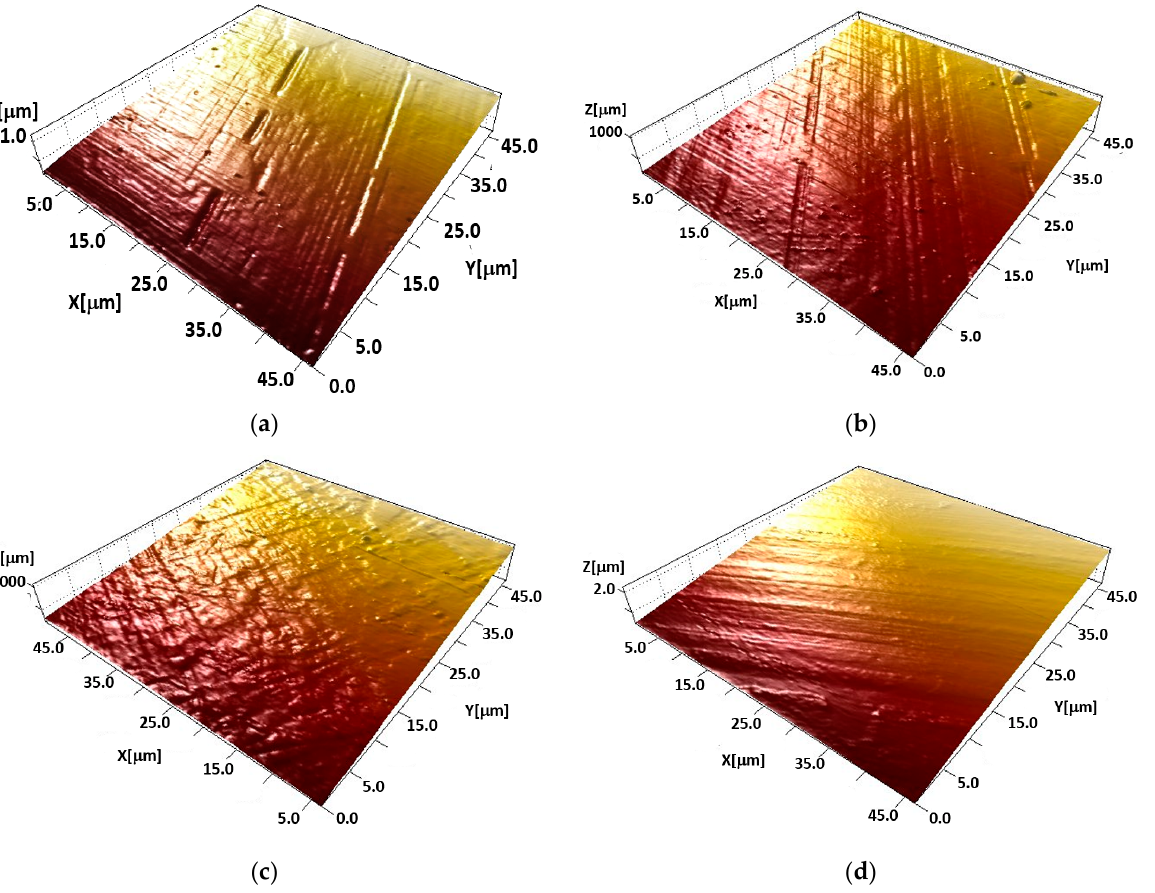
Figure 13. AFM micrographs for HfCN coatings analysed after wear tests. ( a ) 100 °C, ( b ) 200 °C, ( c ) 400 °C and ( d ) 800 °C. ( c ) 400 ◦ C and ( d ) 800 ◦